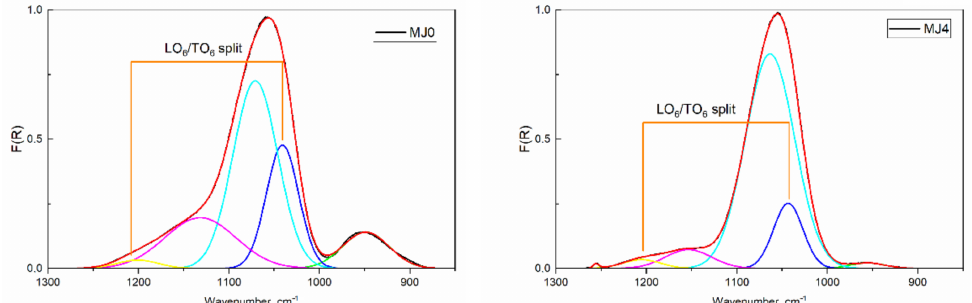
Figure 2. Spectral deconvolution of samples with a different hydrophobization degree: MJ0— hydrophilic silica, left; MJ4— α = 0.7, right. The appearance of the 1260 cm − 1 band is indicative after the addition of the surface-modifying agent TMCS. Table 2. Data extracted from the non-linear deconvolution of the IR spectra of the samples in the region 1300–900 cm − 1 . The relative area of the IR-bands band of samples in the region of the Si-O-Si and Si-OH vibrations. Sample; TO/LO Splitting Peak